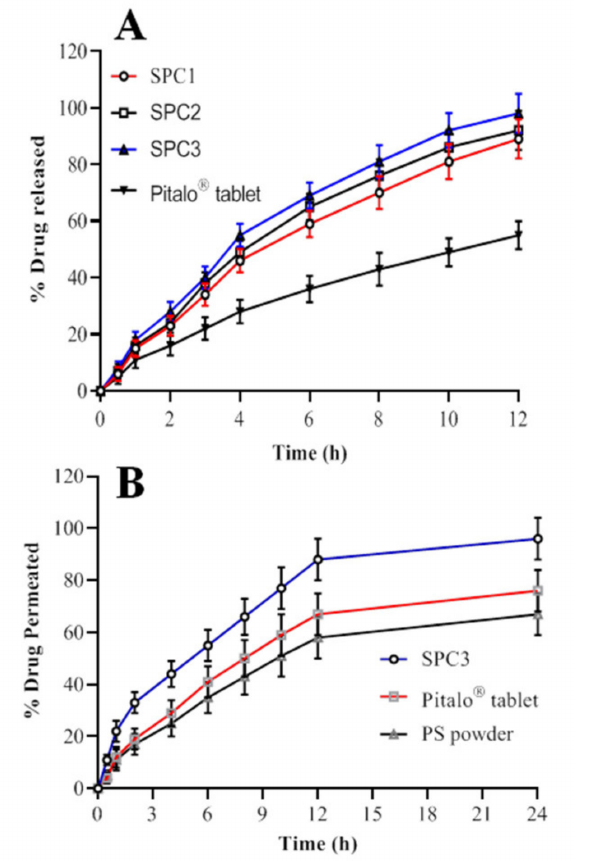
Figure 5. %age drug release ( A ) and %age drug permeated ( B ) of pitavastatin from the SNEDDS